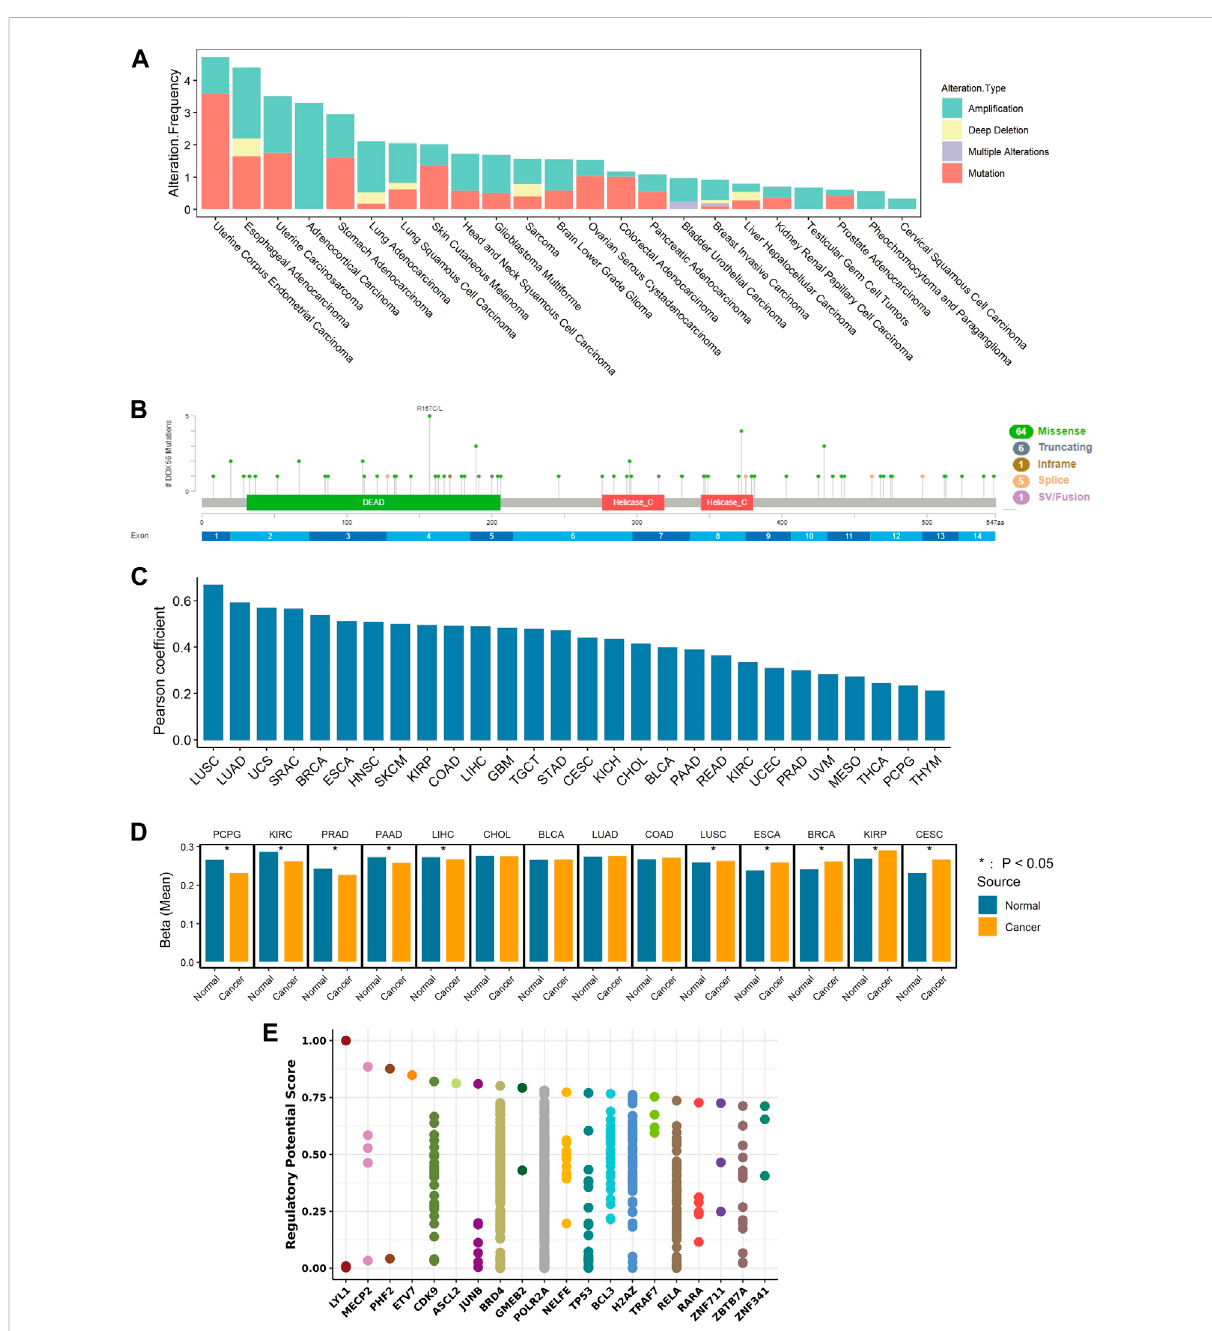
Mechanism of regulation of DDX56 expression. (A) Analysis of DDX56 alteration frequency in multiple cancer types, colored by mutation type. (B) Sites of different mutation types of DDX56 . (C) Bar plot showing the Pearson correlation of CNV and DDX56 RNA expression in different tumor types. (D) BarplotshowingtheDNAmethylationstatusof DDX56 intumorsandnormaltissues. Y -axisindicatesthemeanofthebetavalue.* p < 0.05. ThestatisticsarefromOncoDB. (E) Transcriptionfactorspotentiallyregulating DDX56 (resultsobtainedfromToolkit).Theplotillustratesthetop 20 factors. Dots on a single axis line indicate the same factor. Abbreviations: ACC: adrenocortical carcinoma; BRCA: breast invasive carcinoma; COAD: colon adenocarcinoma; GBM: glioblastoma multiforme; HNSC: head and neck squamous cell carcinoma; KICH: kidney chromophobe; KIRC: kidney renal clear cell carcinoma; LIHC: liver hepatocellular carcinoma; LUAD: lung adenocarcinoma; LUSC: lung squamous cell carcinoma; MESO: mesothelioma; OV: ovarian serous cystadenocarcinoma; PAAD: pancreatic adenocarcinoma; PCPG: pheochromocytoma and paraganglioma; PRAD: prostate adenocarcinoma; READ: rectum adenocarcinoma; SARC: sarcoma; SKCM: skin cutaneous melanoma; STAD: stomach adenocarcinoma; TGCT: testicular germ cell tumors; THCA: thyroid carcinoma; THYM: thymoma; UCEC: uterine corpus endometrial carcinoma; UCS: uterine carcinosarcoma; UVM: uveal